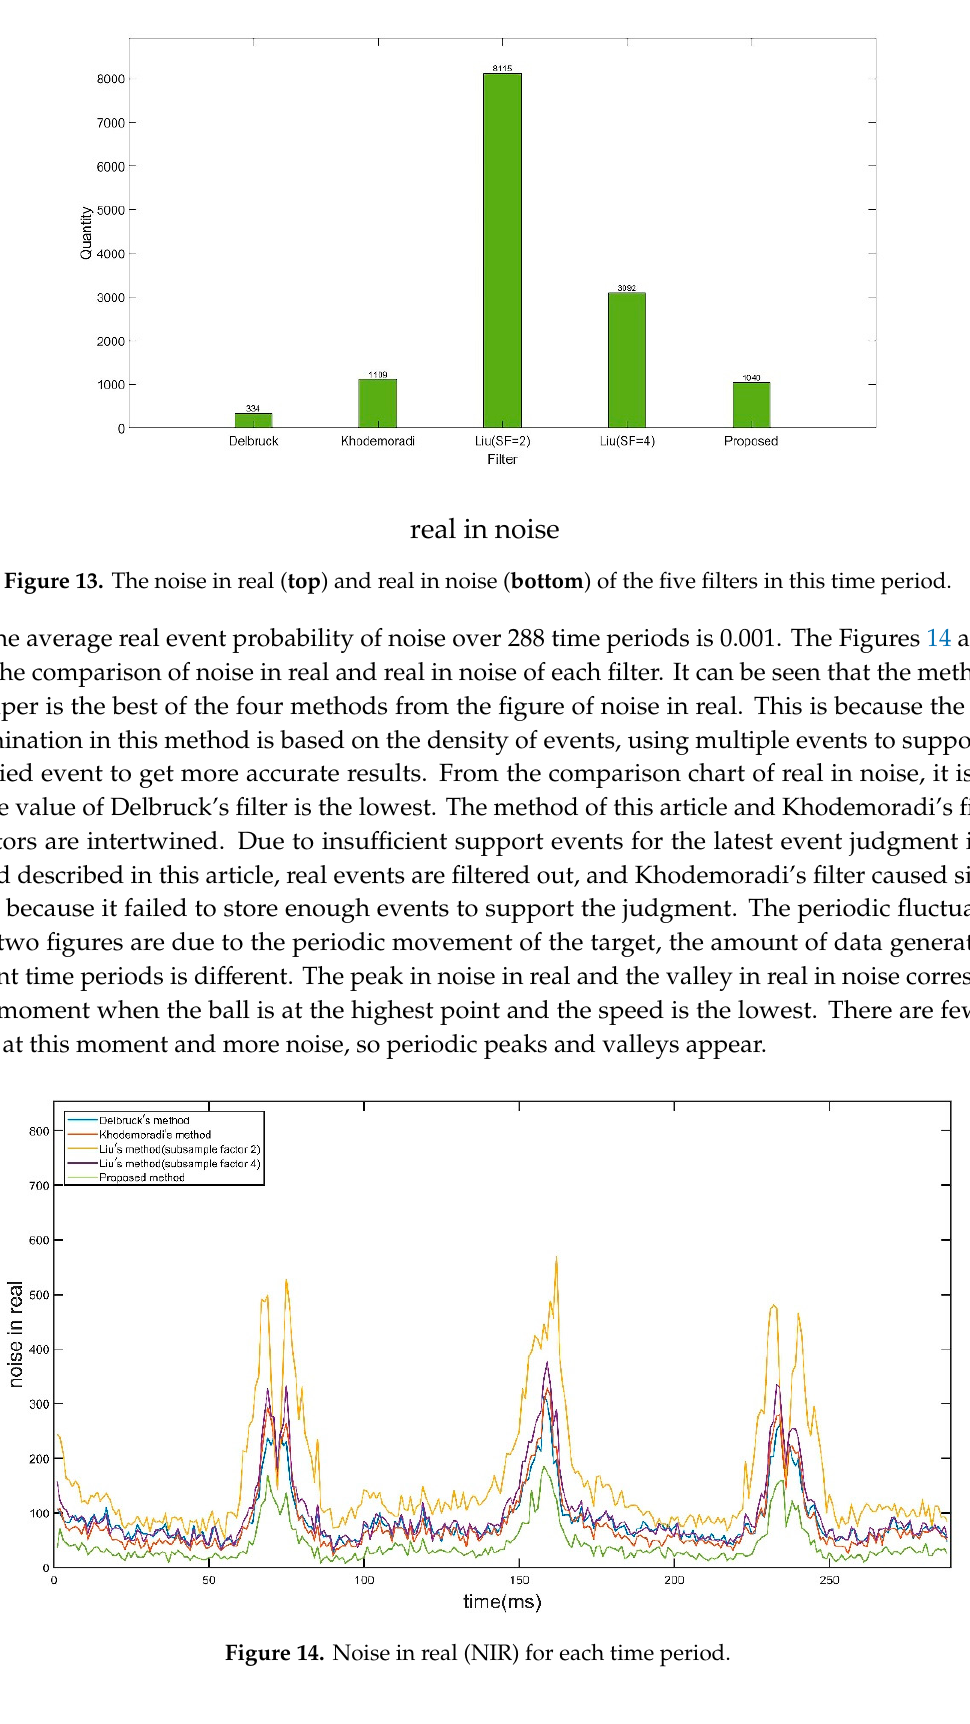
Figure 14. Noise in real ( NIR) for each time period.